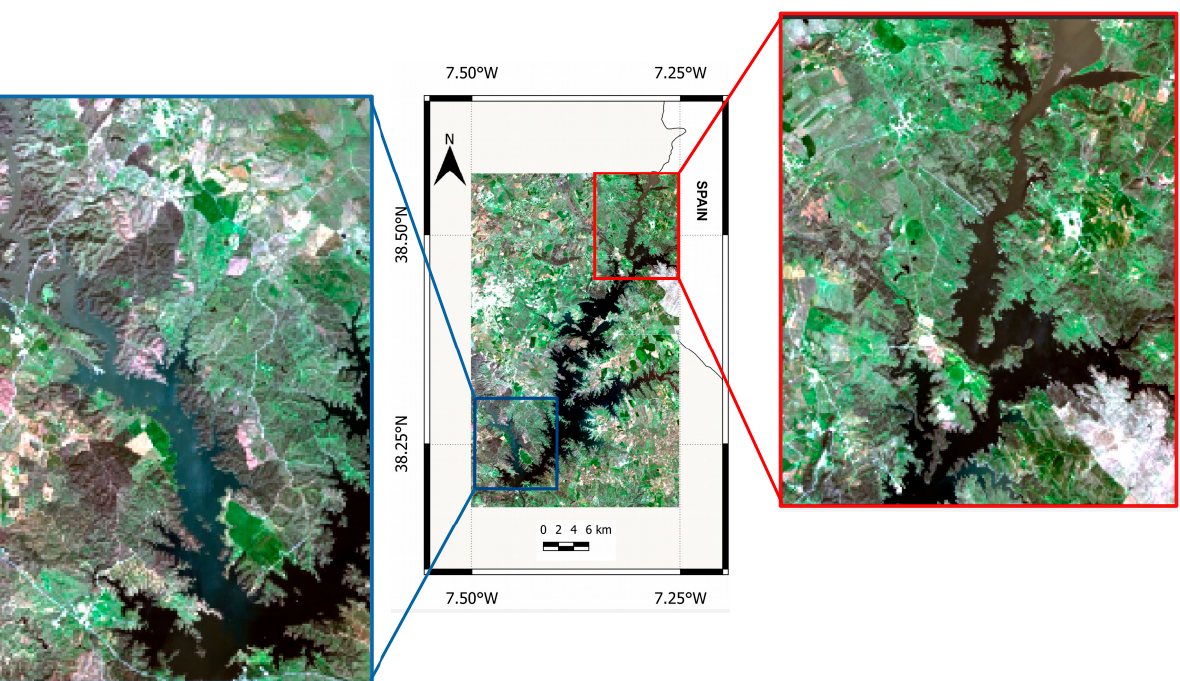
Figure 14. RGB image and more detailed images of the north and west areas on 26 March 2018 in the Alqueva reservoir.